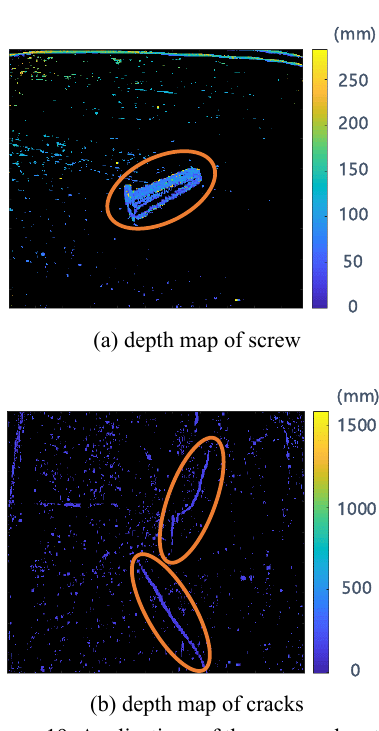
Figure 17. Sensitivity analysis of weight